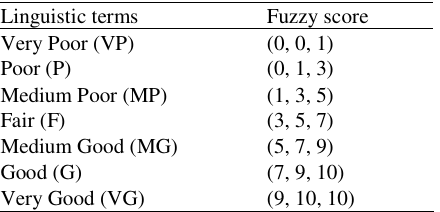
Table 3: Fuzzy evaluation scores for the alternatives Linguistic terms Fuzzy